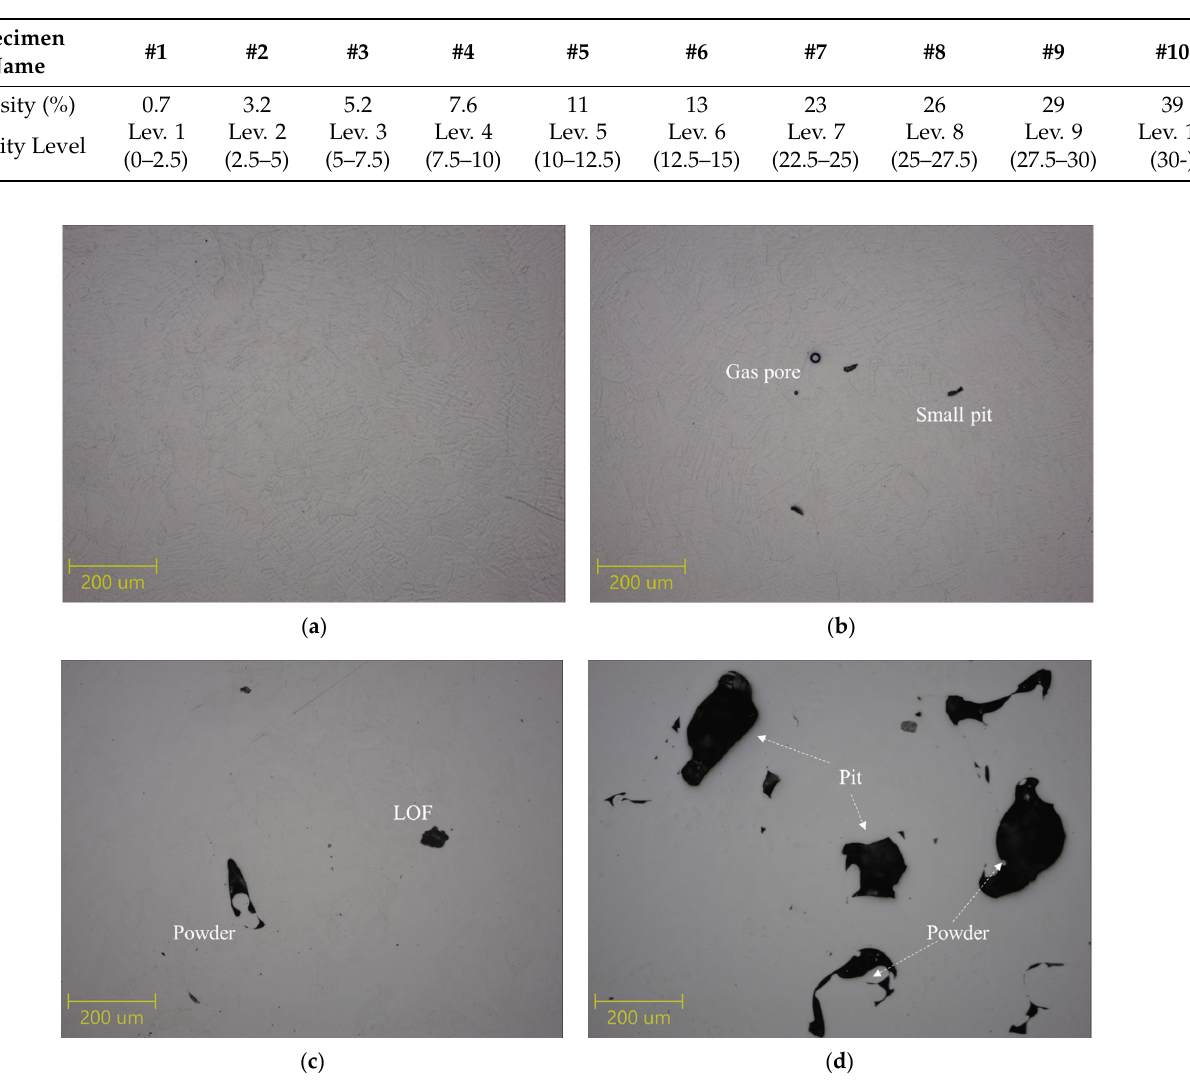
Figure 3. OM images of specimens ( a ) #1, ( b ) #3, ( c ) #6, and ( d ) #10.